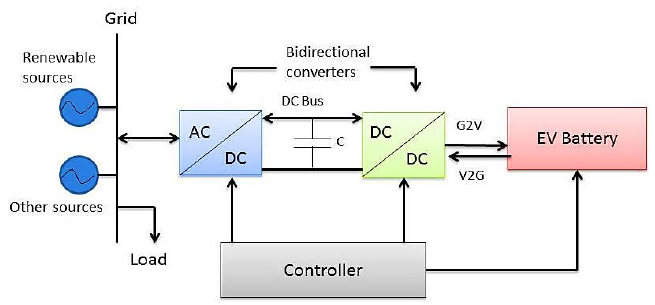
Figure 1. Two-stage off-board DC charger for EVS.